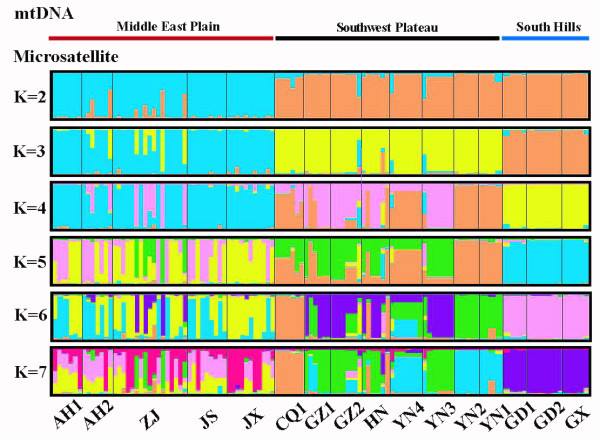
Graphic derived from the program STRUCTURE. We repeated the Bayesian clustering analysis with STRUCTURE and assigned individuals into clusters at values of K beyond the number considered to maximize the posterior probability and reconstruct the hierarchical relationship among populations. Each individual is represented by a vertical line which is partitioned into K colored segments, the length of each color being proportional to the estimated membership coefficient. Black lines separate individuals of different populations as indicated by the labels at the bottom of the figure. Graphical represented clusters for samples in the Middle East Plain, Southwest Plateau and South Hills. Each individual is depicted by a horizontal line, which is partitioned into K colored sections. Labels above the figure indicate the three lineages (MEP, SWP and SH) based on ML tree.